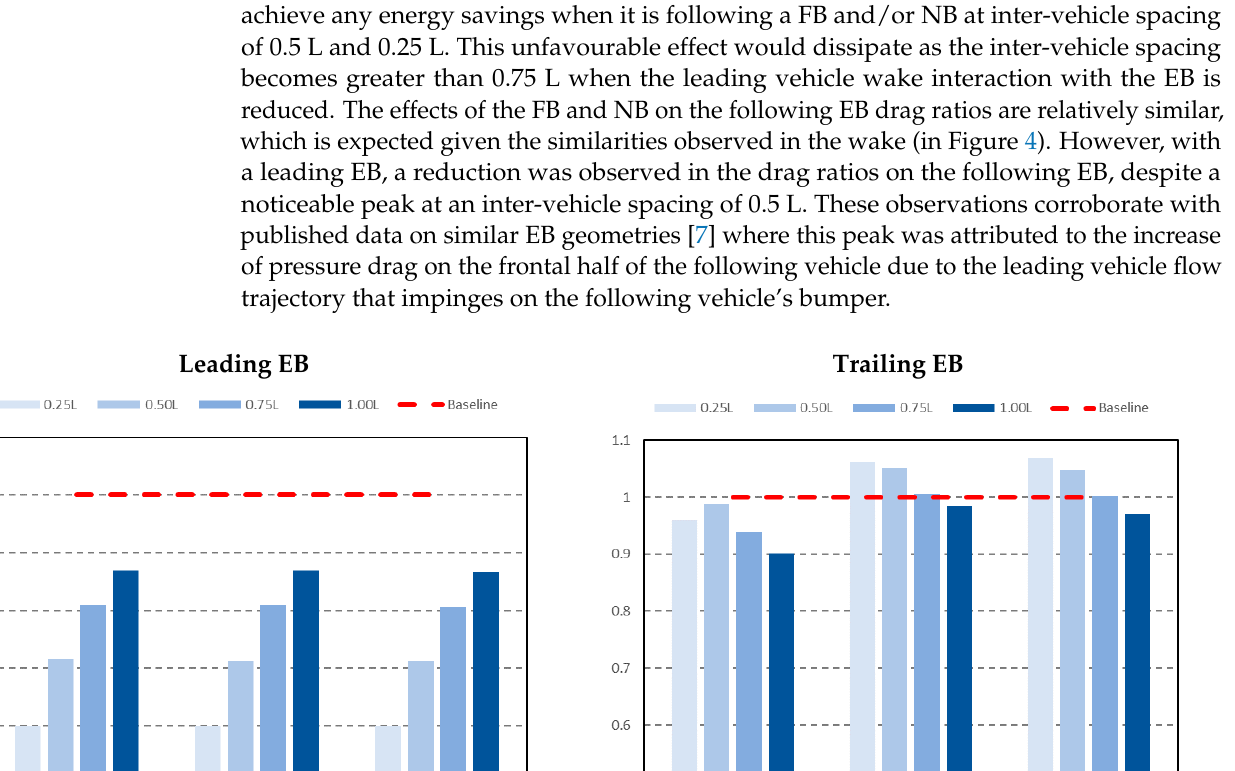
Figure 6. Drag ratios results of a leading FB ( left ) and a trailing FB (right ) in different inter-vehicle spacing and configu- ration order normalised against the baseline results of an FB. 3.2.3. Notchback Geometry Figure 7 shows that the results and trends obtained for the NB geometry are unmistak- ably similar to those observed from the FB geometry with marginal differences in the abso- lute ratios. This is again expected from the baseline analysis conducted on both geometries which indicated very small differences in aerodynamic performance. Therefore, any con- clusions made on the NB geometry are congruous to those made on the FB.